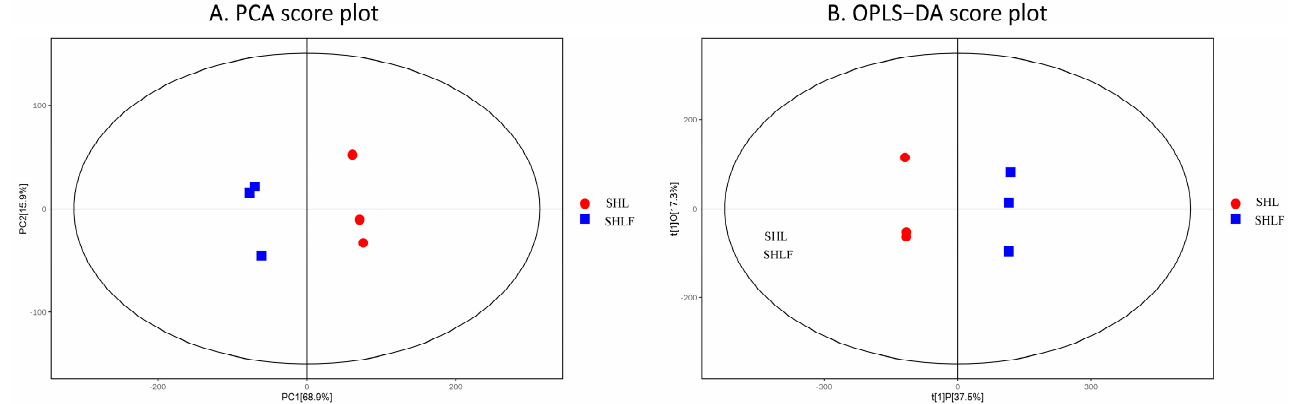
Figure 2. PCA and OPLS-DA score plot of the SHLF group versus the SHL group ( n = 3). ( A ) PCA score plot; ( B ) OPLS-DA score plot.